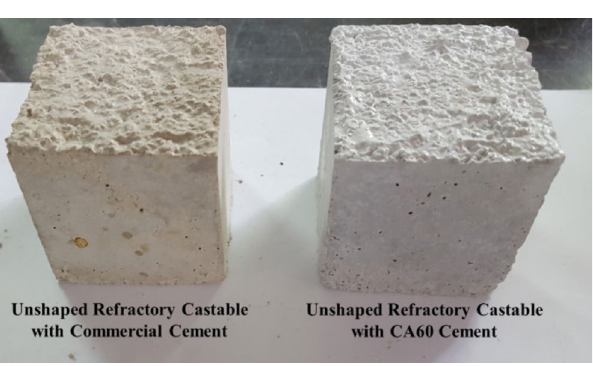
Figure 12. Unshaped refractory castables using CA60 sintered at 1450 °C and commercial